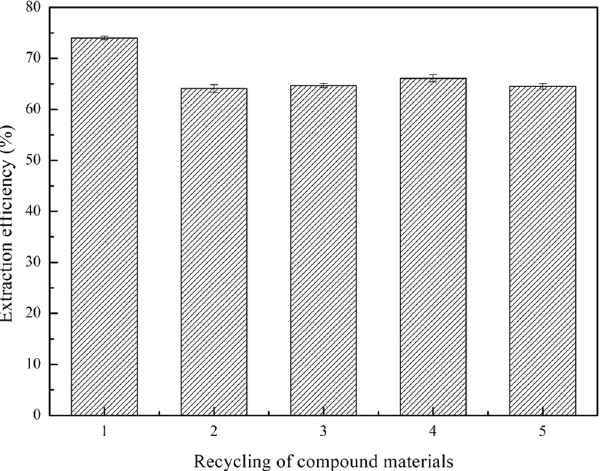
Figure 11. The effect of recycling on the extraction efficiency (experimental conditions: 1.2 g (TBAC/2p- TsOH)/rGO, 0.5 g simulated oil (1600 mg/L sulphur content), 0.25 g H 2 O 2 , 25 °C, 800 rpm, 60 min).